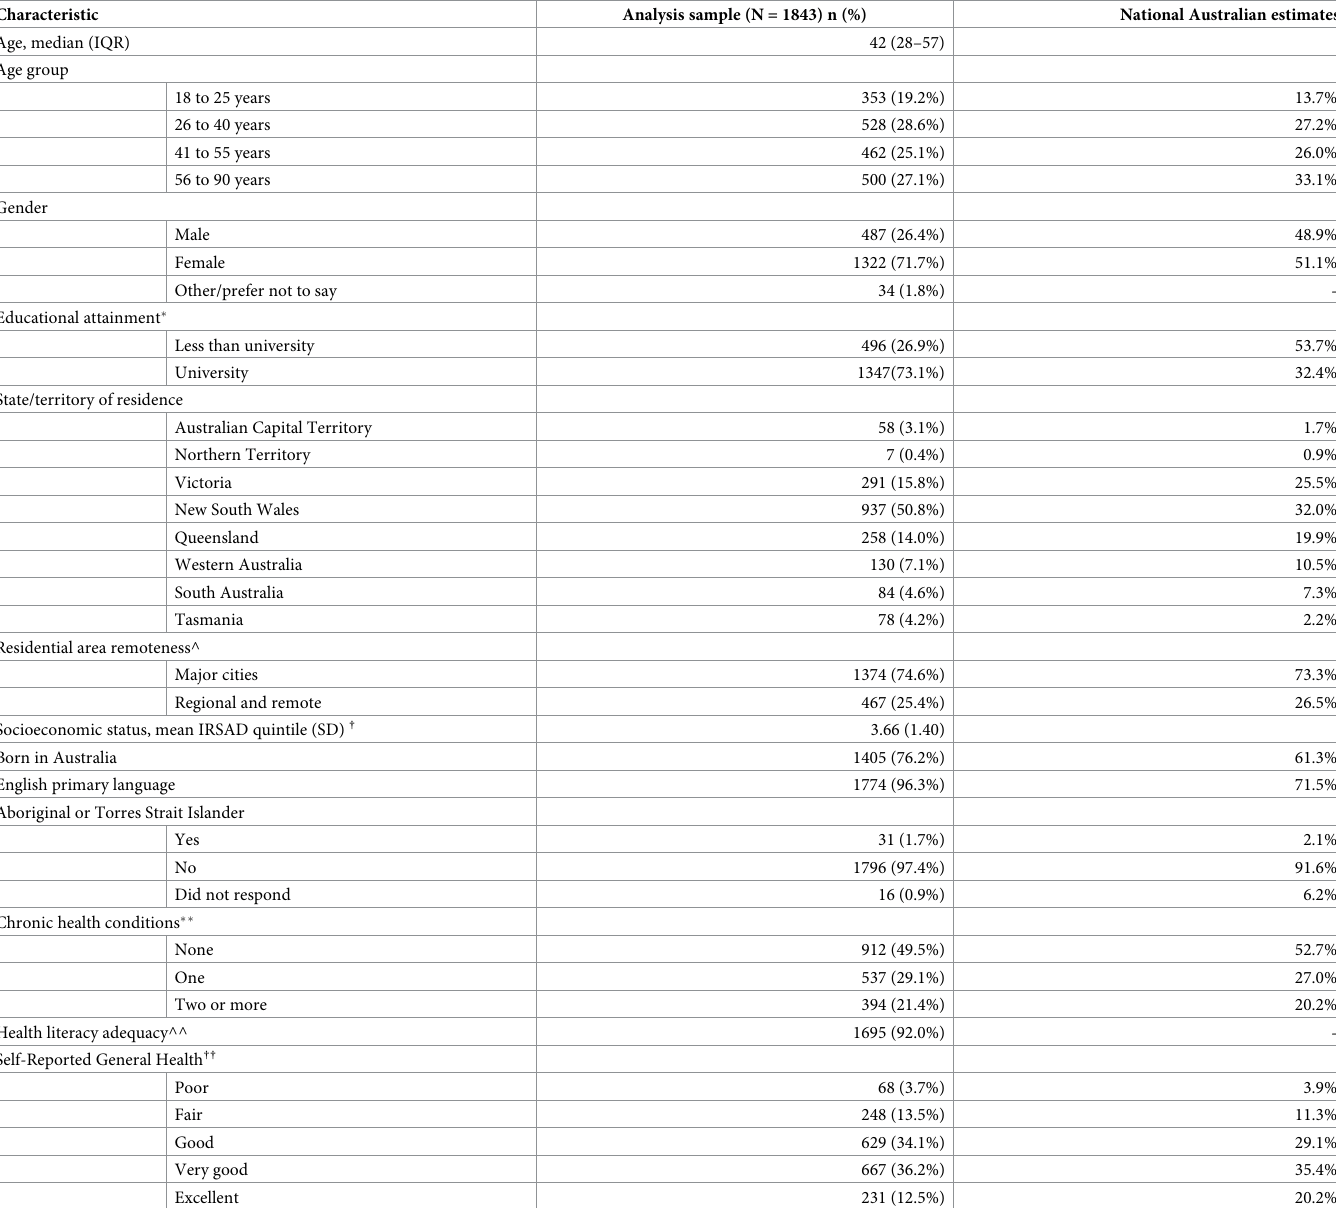
Table 2. Descriptive characteristics of analysis sample at baseline (April) (N =